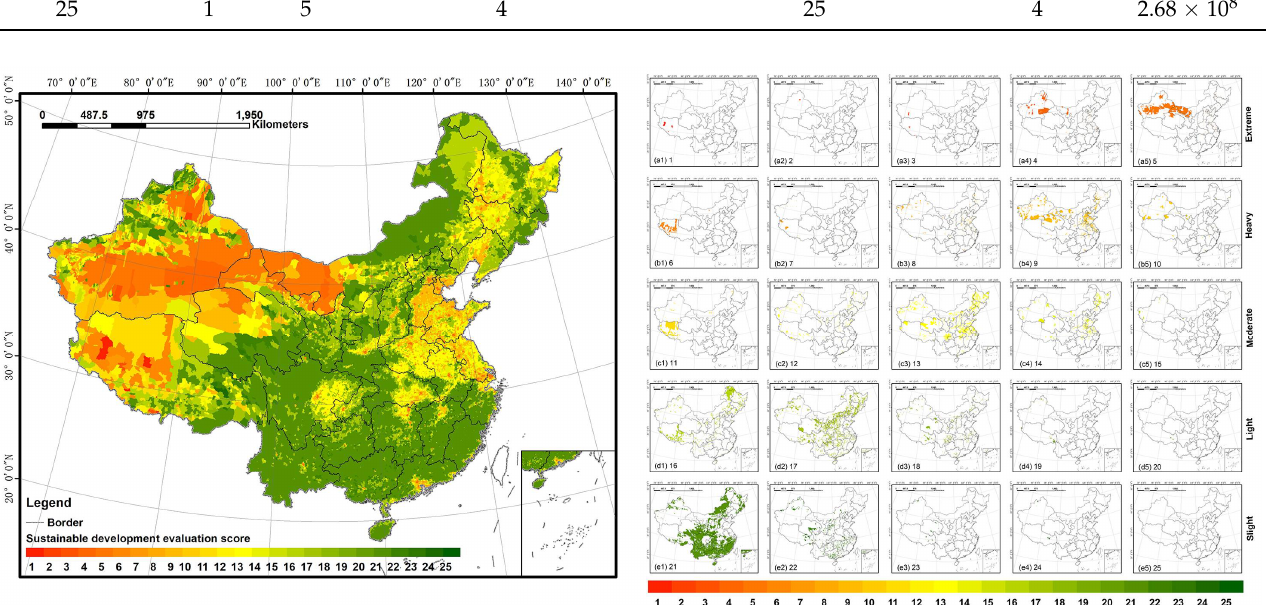
Figure 8. Sustainable–development evaluation score from 2000 to 2015 at the rural–area scale.